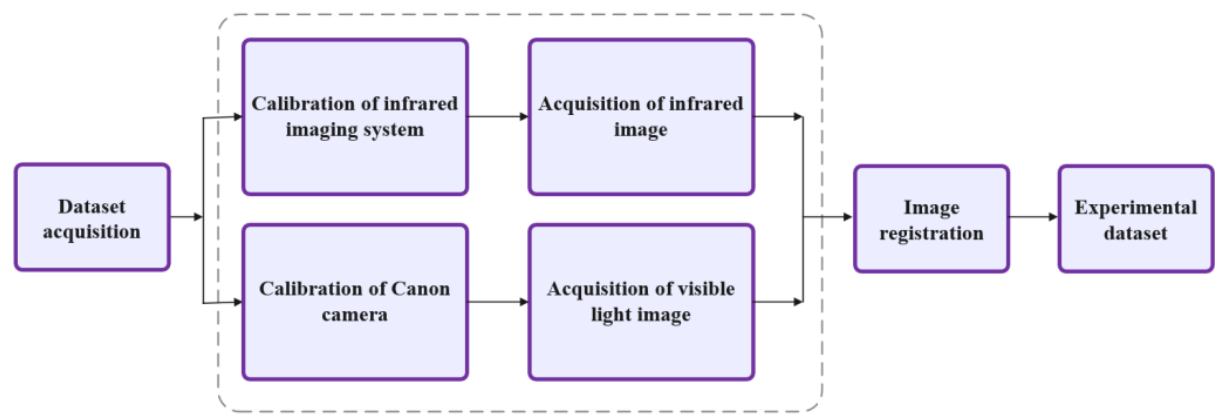
Figure 8. The flow chart of experimental dataset acquisition.